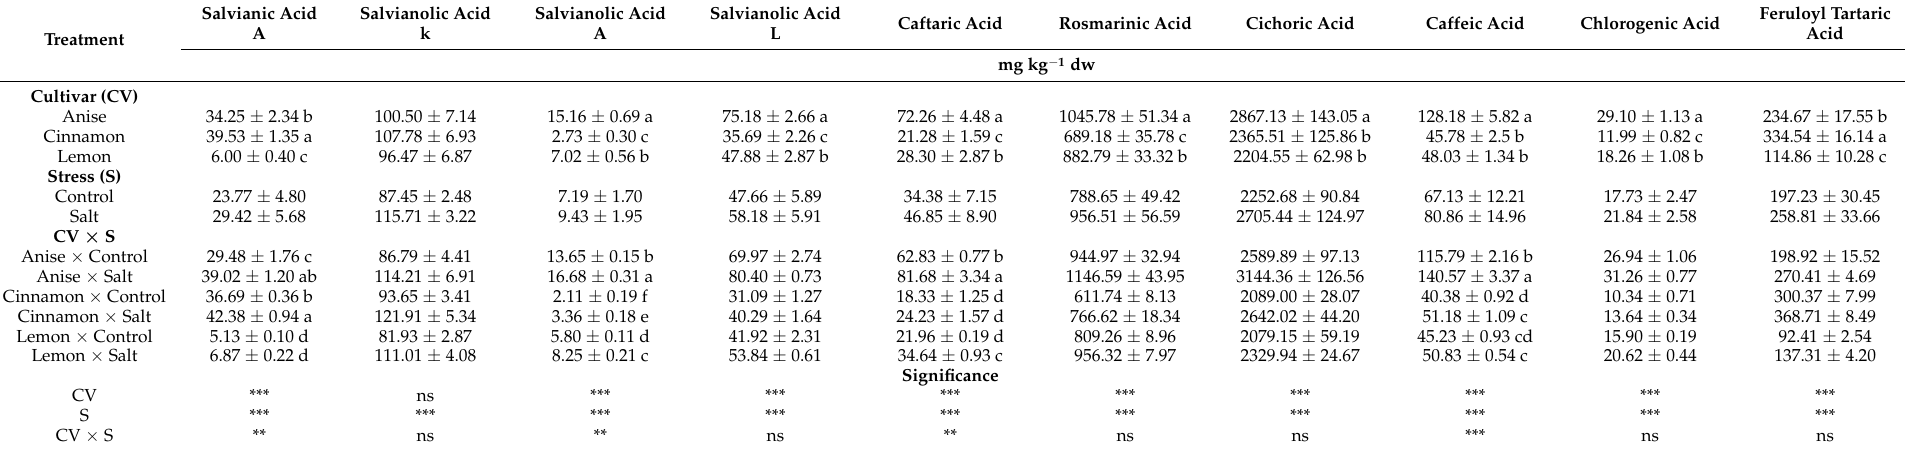
Table 3. Effect of basil cultivars (CV) and stress (S) on phenolic acid